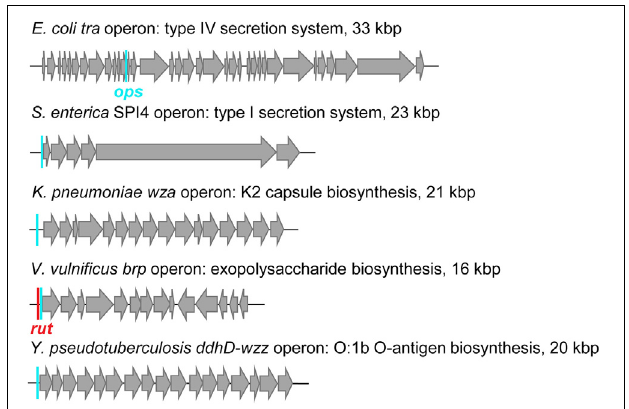
FIGURE 10 | Examples of RfaH-controlled operons. Positions of ops sites (cyan bars) and a rut site (red bar) are indicated.